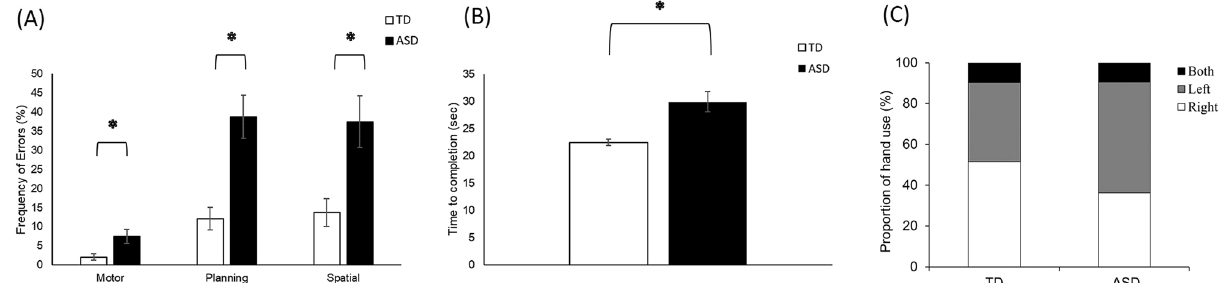
Figure 1. Behavioral errors ( A ), Time to completion ( B ), and Hand preference ( C ) in children with an ASC and TD children. *Indicates significant differences ( p < 0.05 and survived FDR correction) between ASC and TD